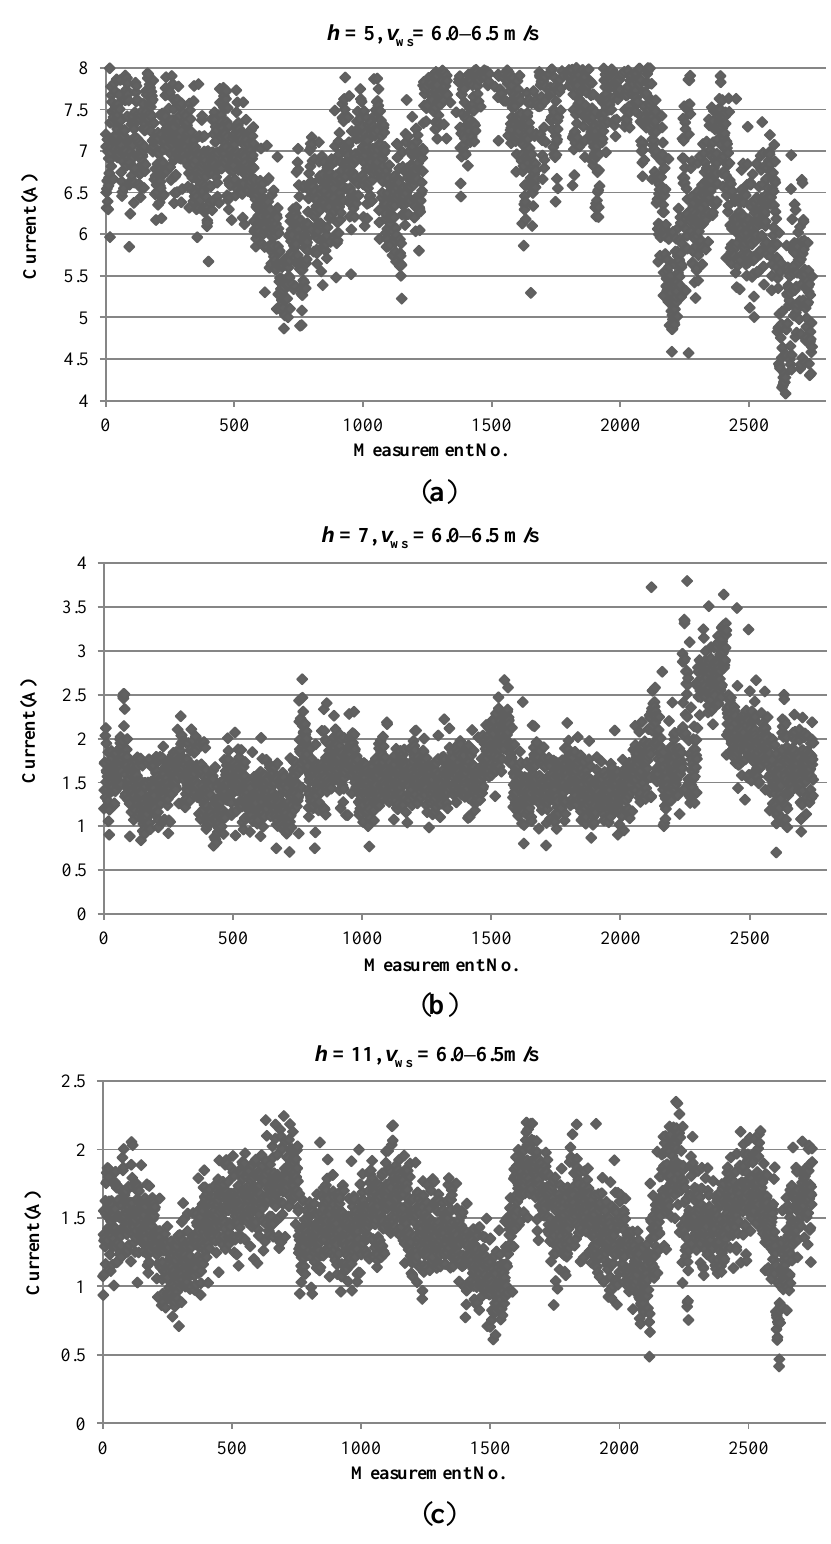
Figure 5. Output characteristics of the 5/7/11th order harmonic currents. ( a ) 5th order harmonic current; ( b ) 7th order harmonic current; ( c ) 11th order harmonic